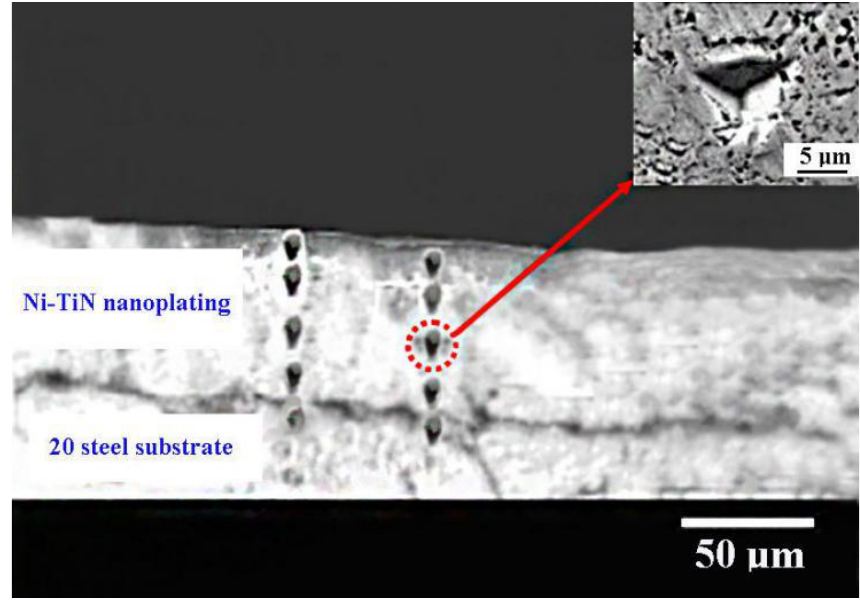
Figure 4. Cross-section of the Ni-TiN nanoplating.